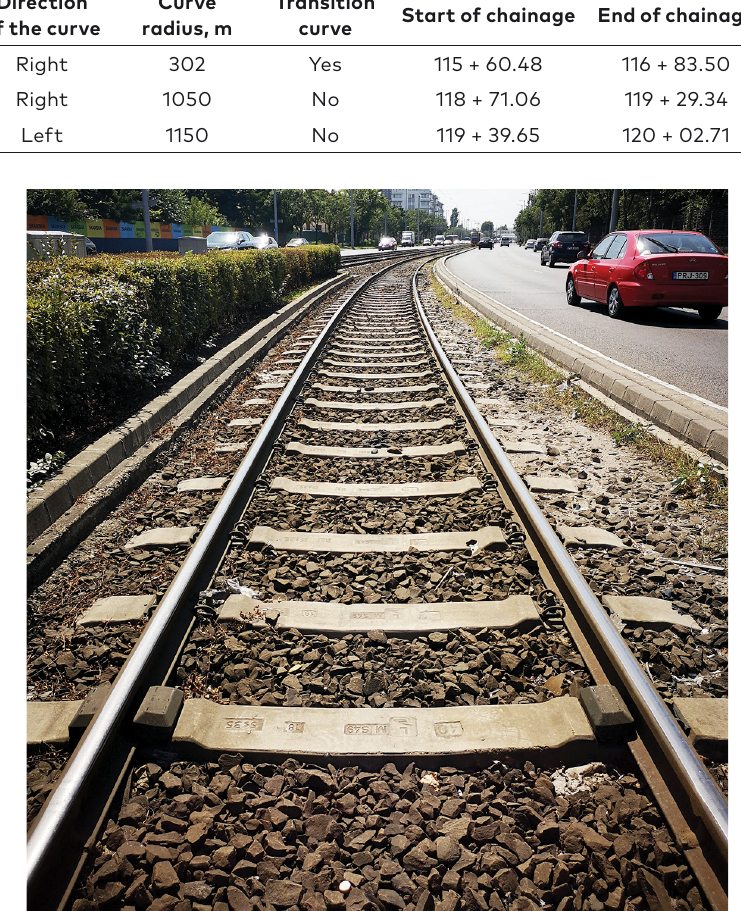
Figure 14. Section 5, 2021 (authors’